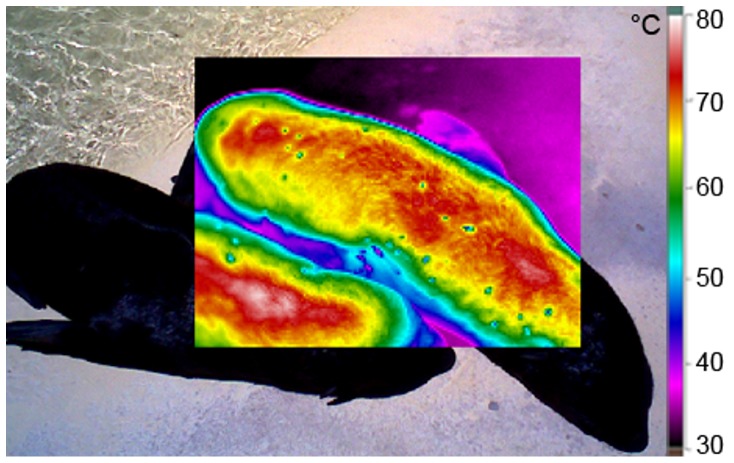
Cape fur seal pups hauling out under intense solar radiation.The pups, aged 18 and 28 days, hauled out in the sun for 1.5 h, Tair  = 31.3°C. Tsurface increased up to 78.7°C on their backs.